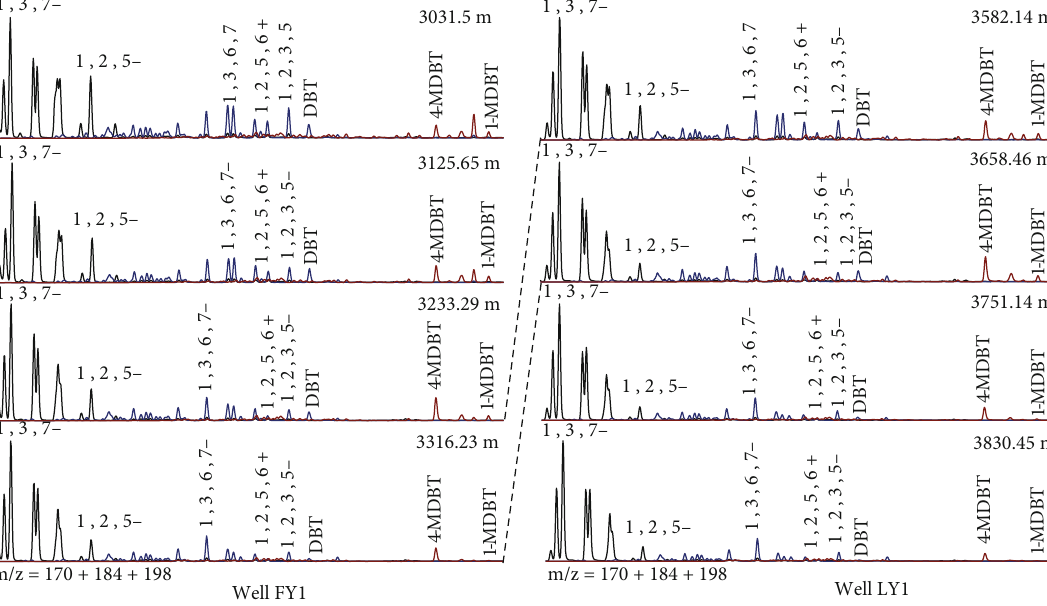
Figure 8: Mass chromatograms of m/z = 170 + 184 + 198 of the aromatic hydrocarbon fraction showing the typical distribution of C3 – C5- alkylnaphthalenes, dibenzothiophene (DBT), and methyldibenzothiophenes (MDBT) with increasing burial depth in wells FY1 and